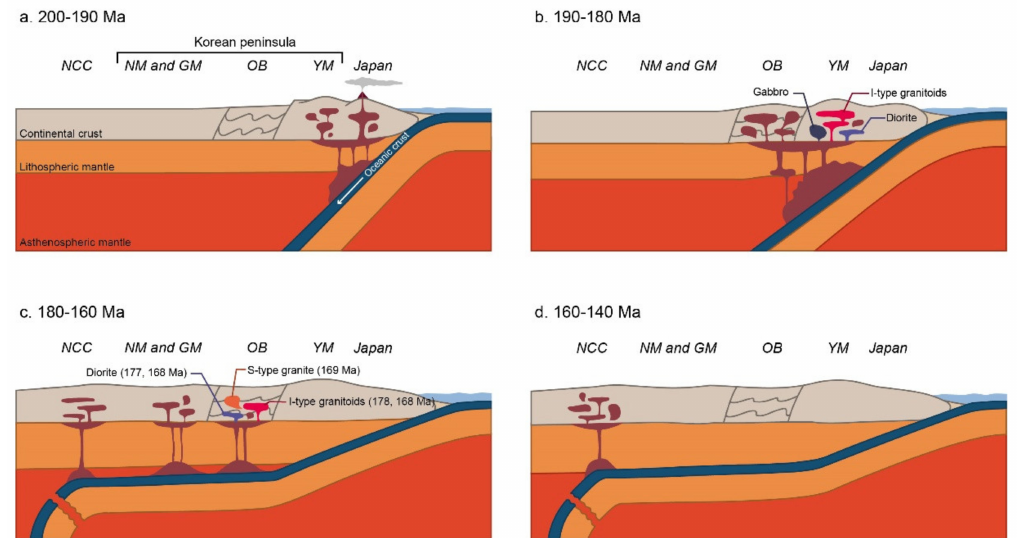
Figure 10. Tectonic evolution model during Jurassic period in the northeastern Asian continent, including the Korean Peninsula and the northeastern part of the North China Craton (NCC). ( a ) 200–190 Ma: Arc-related igneous activities in Japan and the Yeongnam massif in the Korean peninsula. ( b ) 190–180 Ma: Igneous activities in the YM and OB, with no magmatism in Japan, due to migration of the arc front into the southern margin of the Okcheon Belt in the Korean Peninsula. ( c ) 180–160 Ma: Igneous activities in the OB, GM, and NM in the Korean Peninsula and the NCC, due to the flat subduction of the Paleo-Pacific plate. ( d ) 160–140 Ma: Igneous activities in the NCC until 140 Ma with no magmatism in the Korean peninsula, due to the cooling of the subducted flat slab. The abbreviations of tectonic units are explained in Figure